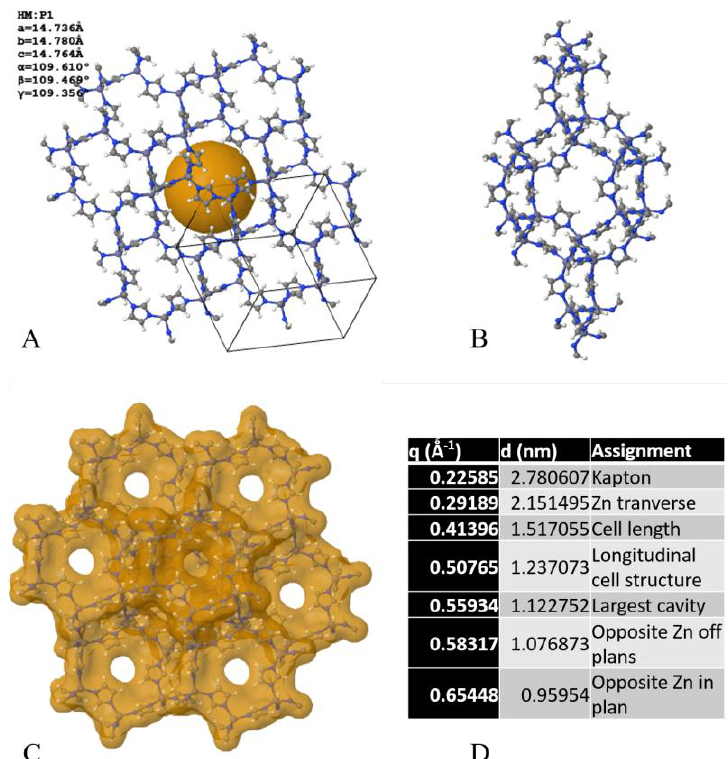
Figure 2. ( A ) Front view of the crystallographic structure of ZiF-8 and ( B ) side view of the cell, corresponding to a cubic body-centred structure; ( C ) corresponding pore structure and molecular surface for adsorption [17], with ( D ) equivalent scattering vectors peak positions assignments and critical dimensions modelled and calculated with [18].